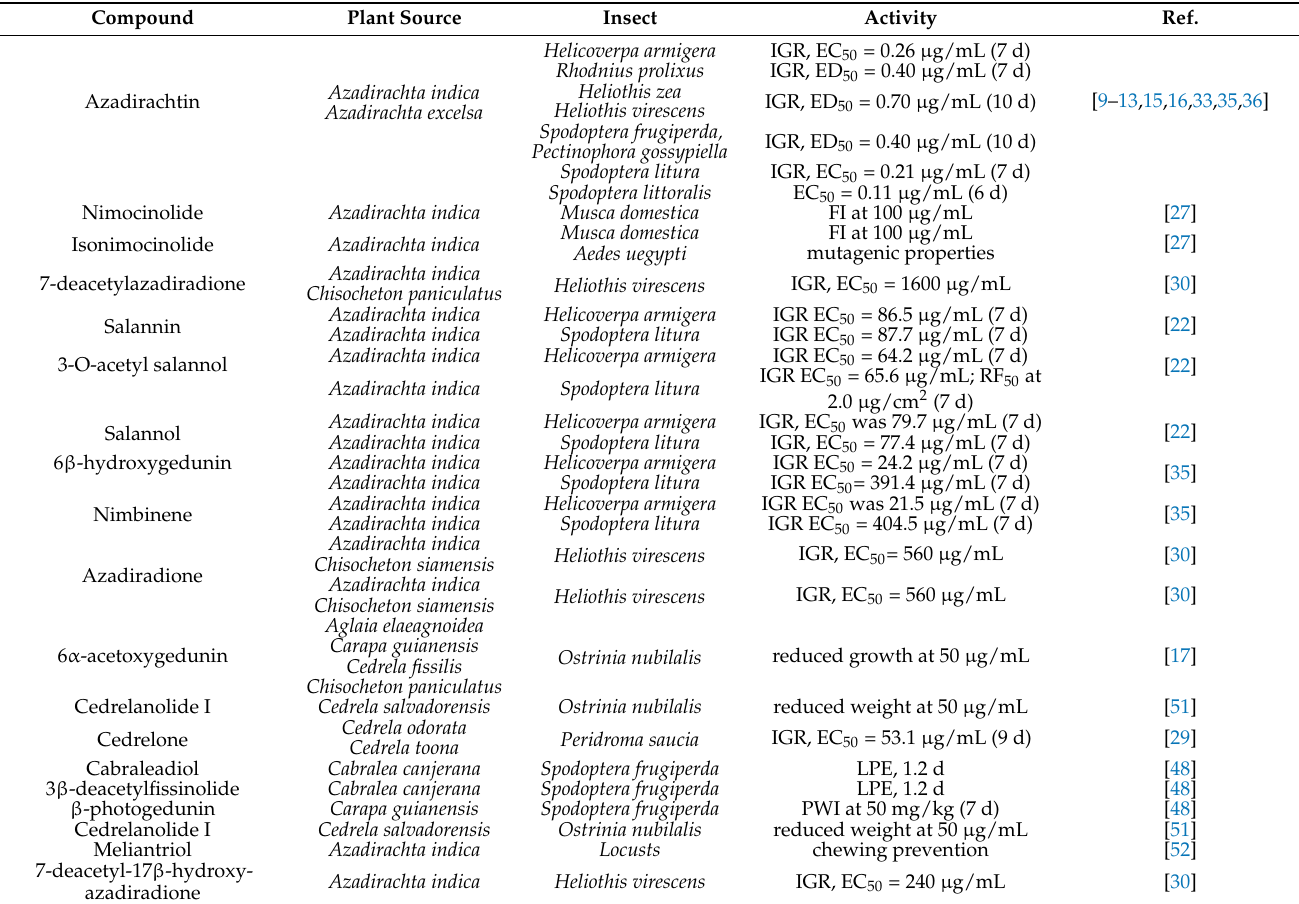
Table 4. Growth regulatory activity of insecticidal triterpenoids of plants from 8 genera in Meliaceae.